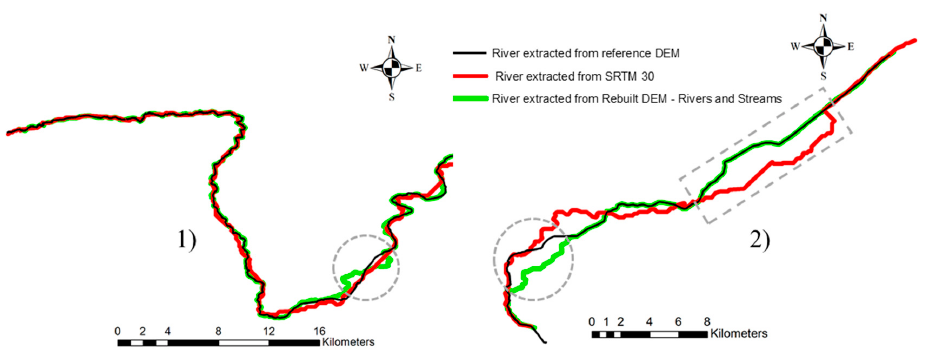
Figure 23. Horizontal positional of the river sections indicated in Figure 22 extracted from the reference (in black), from SRTM 30 (in red) and from the rebuild DEM using OSM rivers and streams (in green).